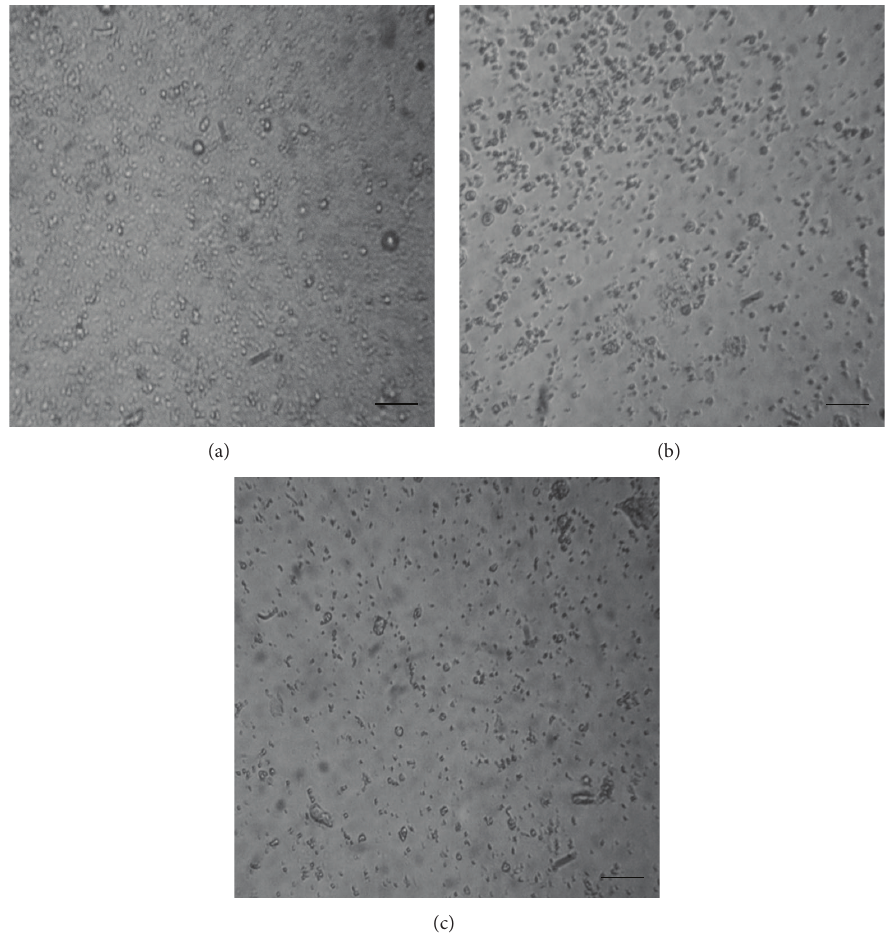
Figure 2: Optical microscopy of E. granulosus larval cells treated for 7 days with R. officinalis essential oil. (a) Control. (b) Cells treated with 5 𝜇 g/mL. (c) Cells treated with 10 𝜇 g/mL. Bar = 40 𝜇